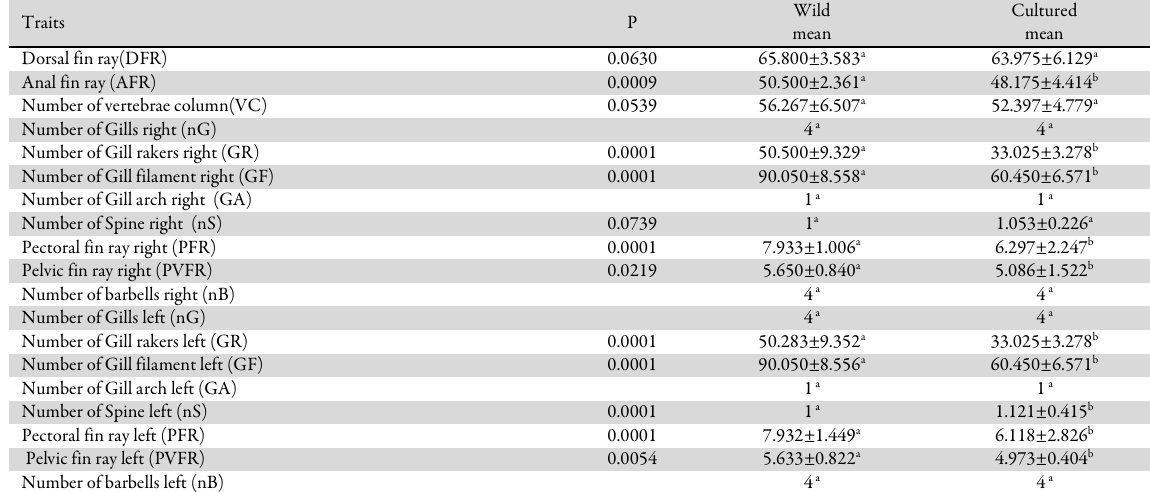
Table 2. The probabilities and means of meristics of wild and cultured Clarias gariepinus from two populations in Ekiti State Traits